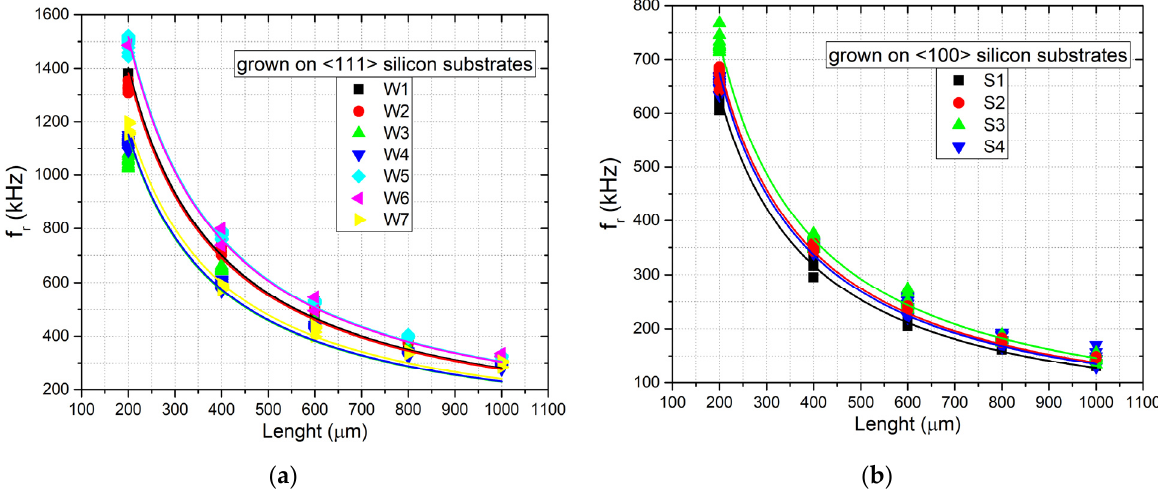
Figure 11. First-order resonance frequency versus length of the double clamped beams for the samples with n-type doping grown on ( a ) <111> and ( b ) <100> silicon substrates. The continuous lines are the data fittings obtained with Equation (2).